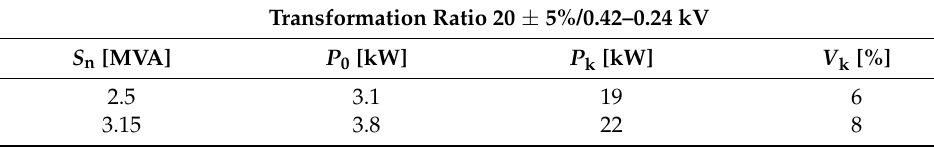
Table 8. Electrical data of the MV/LV